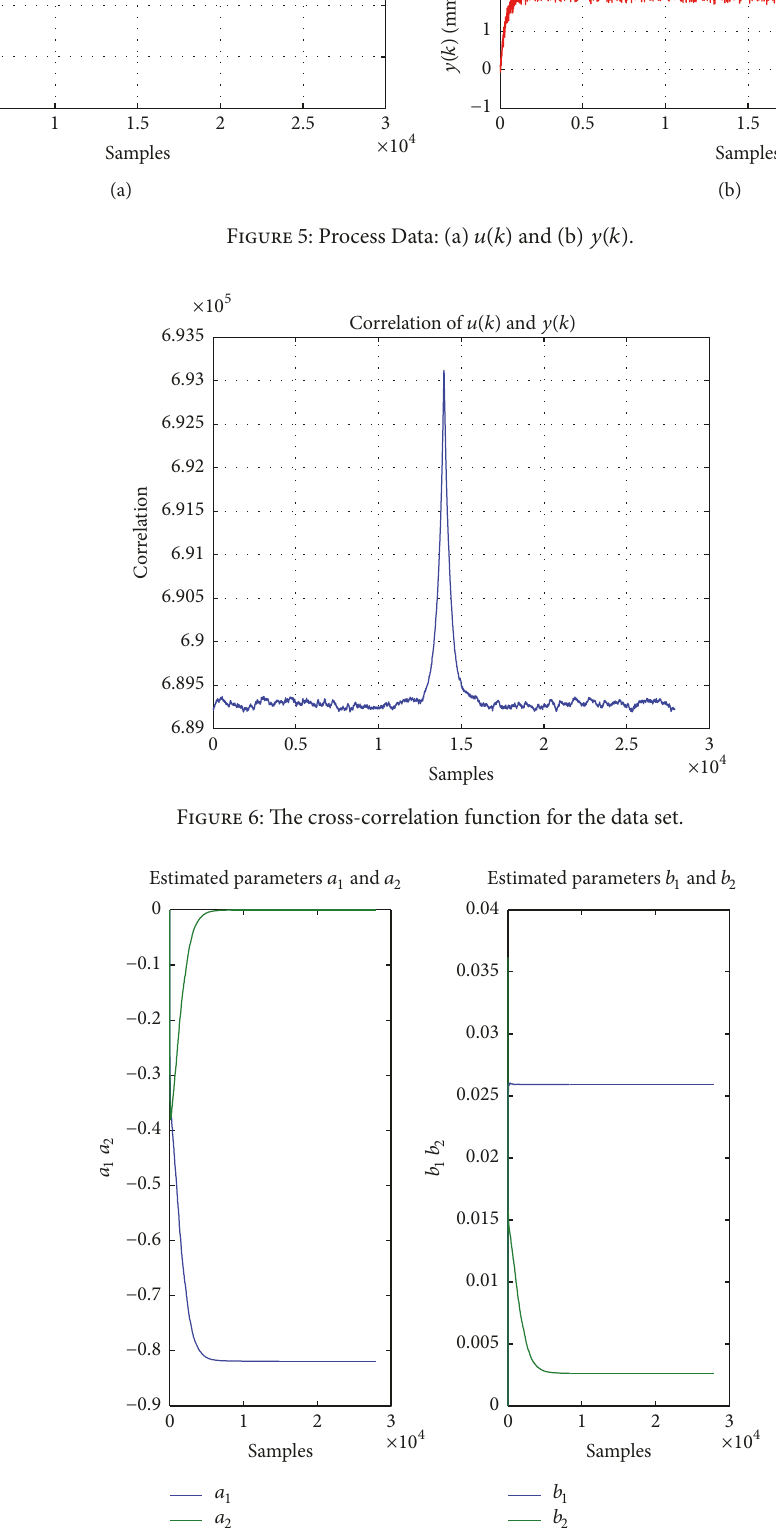
Figure 7: Estimated process parameters using